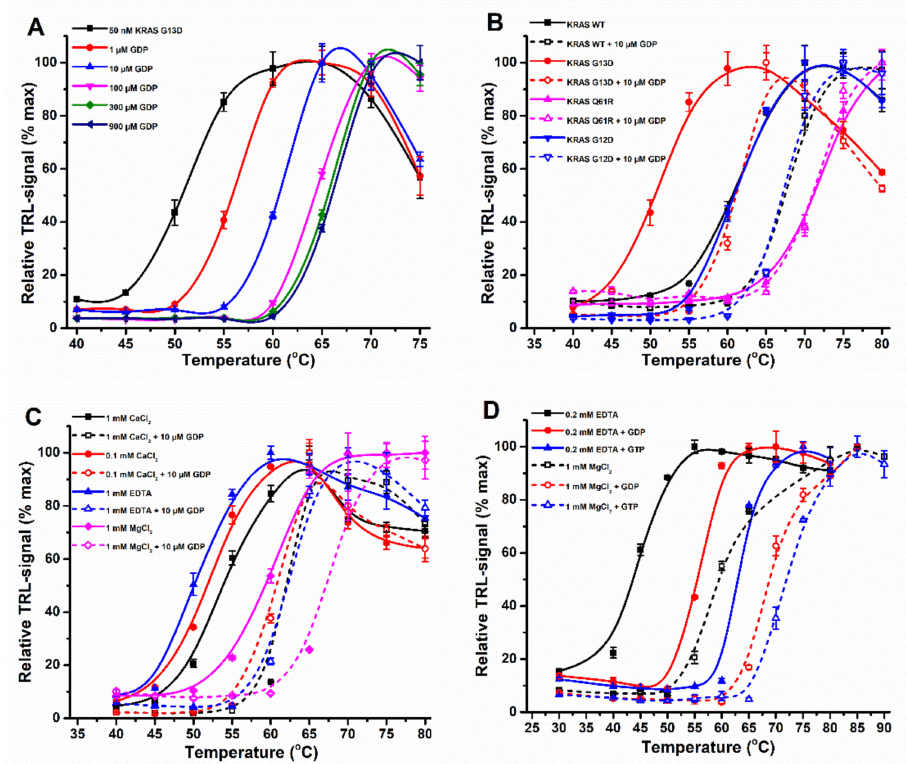
Figure 2. KRAS and other small GTPases were stabilized by GDP/GTP in the Protein-Probe assay. ( A ) KRAS G13D (50 nM) stability was determined in the presence of free GDP (0–900 µ M). KRAS G13D (black) was significantly thermally stabilized with 1 µ M GDP (red). GDP-induced stabilization of KRAS G13D further increased with 10 (blue) and 100 µ M (magenta) GDP and was saturated at approximately 300 µ M (green) concentration, without further change with 900 µ M GDP (navy). ( B ) KRAS (50 nM) thermal stabilization in the absence (solid line) or presence (dashed line) of additional GDP (10 µ M) was dependent on its mutational status. KRAS G13D (red) was more responsive to GDP addition in comparison to KRAS WT (black) or G12D (blue). KRAS Q61R (magenta) was not stabilized by the addition of GDP. ( C ) GDP-induced KRAS WT (50 nM) stabilization was not dependent on divalent cations. Both 0.1 (red) and 1 mM (black) Ca 2+ stabilized KRAS, but to a lesser extent than 1 mM Mg 2+ (magenta), when compared to KRAS with 1 mM EDTA (blue). In all buffers, 10 µ M GDP (dashed line) addition stabilized KRAS in comparison to buffer without additional nucleotide (solid line). ( D ) RhoA WT (2 µ M) nucleotide-specific stabilization was more significant in the presence of 0.2 mM EDTA (solid) than with 1 mM Mg 2+ (dashed). RhoA (black) stability increased significantly more with 100 µ M GTP (blue) than GDP (red). Difference in GTP preferred stability increase was more significant in the absence of Mg 2+ . Data represent mean ± SD ( n =